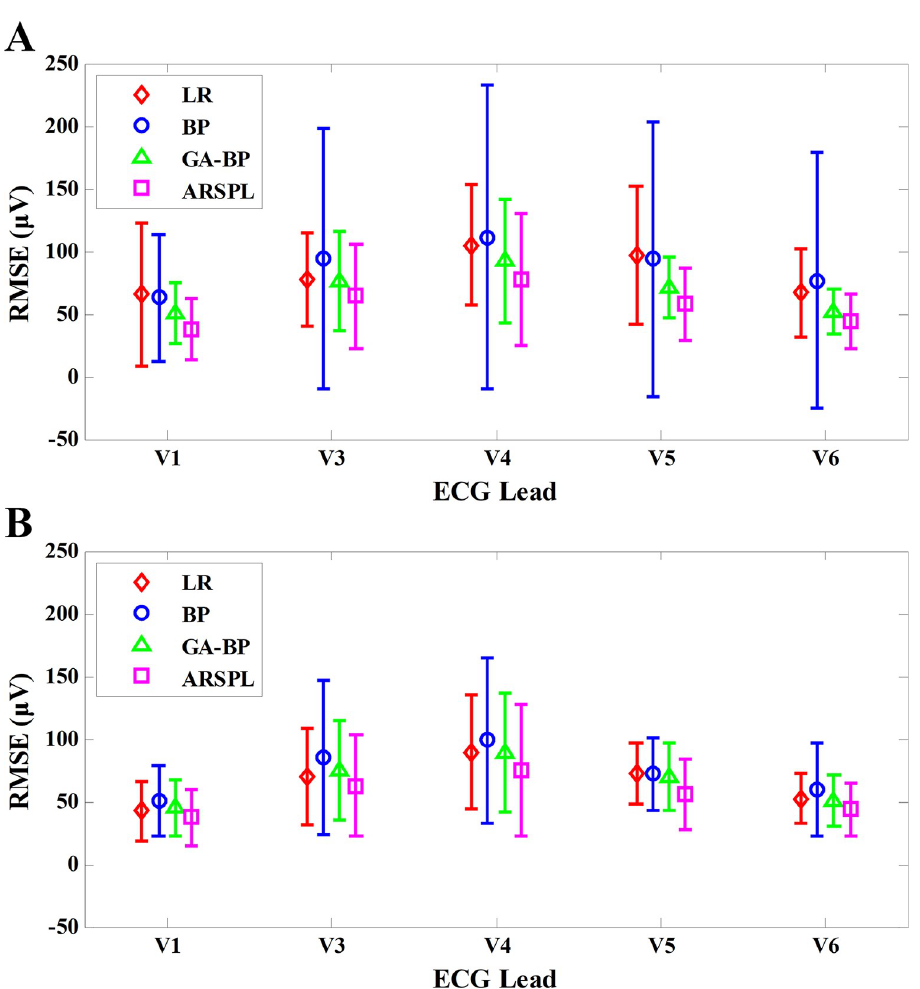
Fig 6. RMSE results of each lead for the basic/best cases. (A) RMSE comparison in the basic case. (B) RMSE comparison in the best